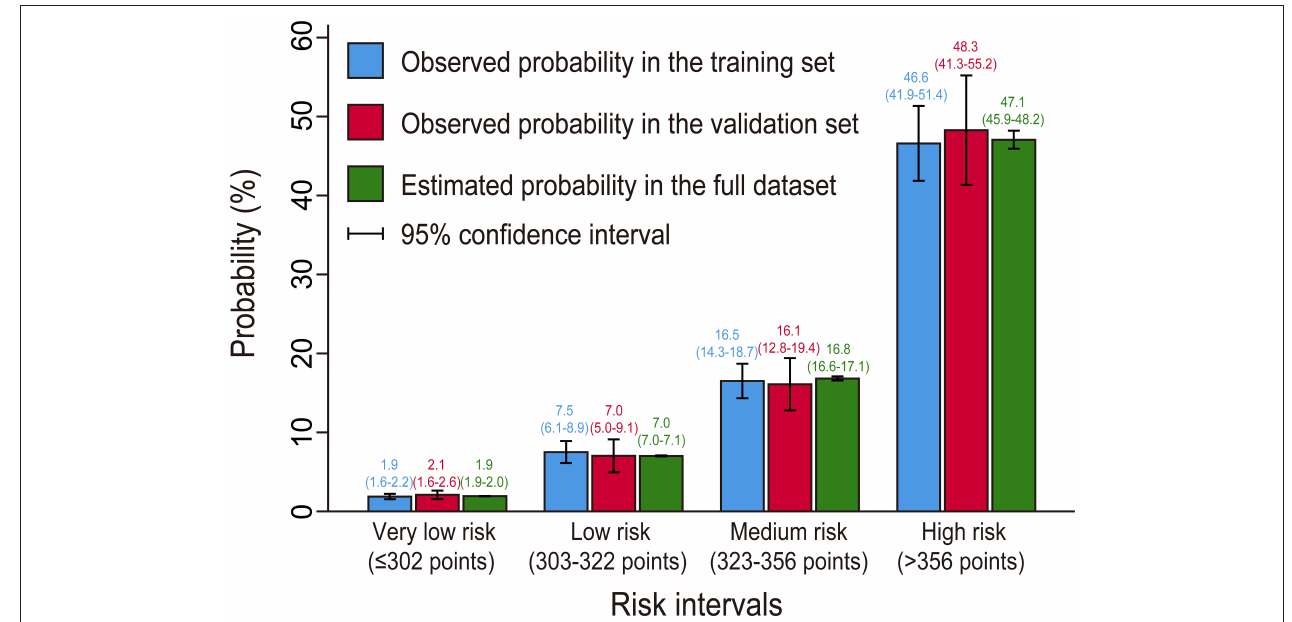
FIGURE 5 | Bar chart showing the agreement between estimated and observed probabilities.